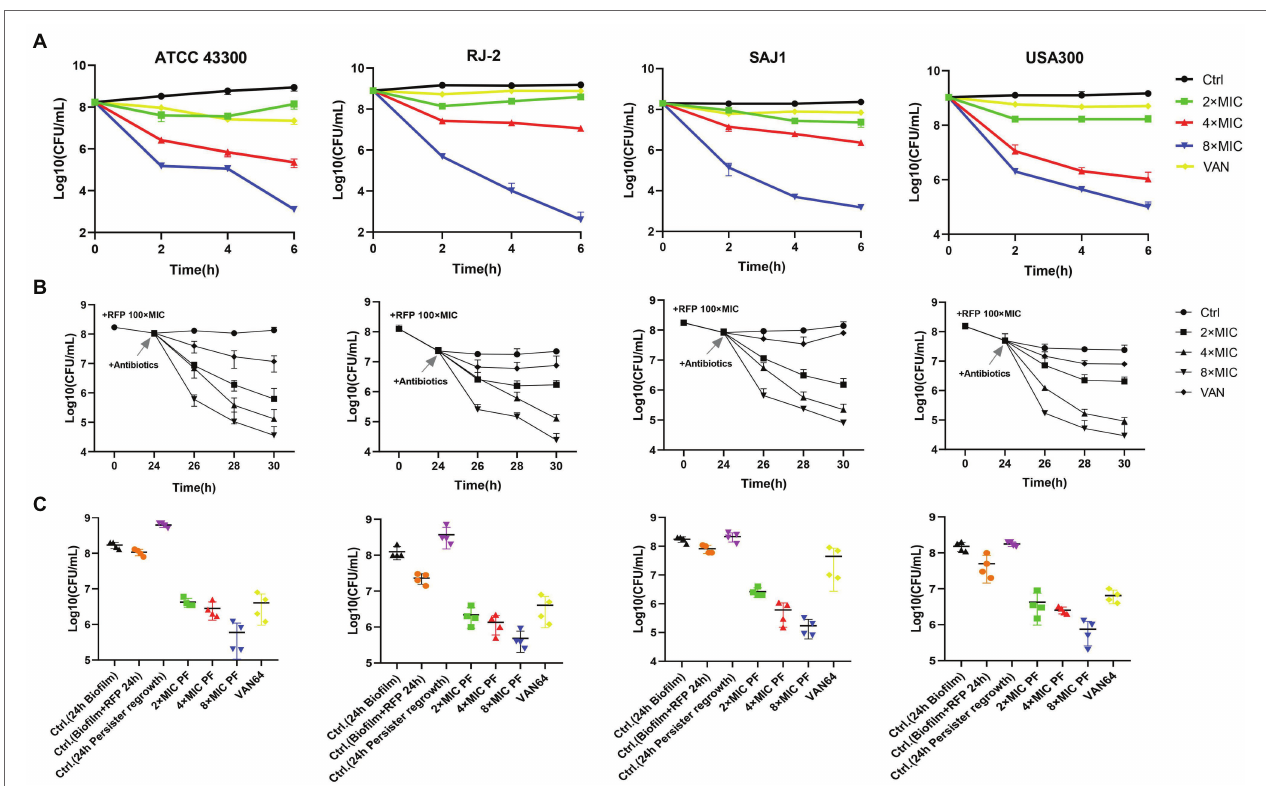
FIGURE 3 | Penfluridol shows strong bactericidal activity against methicillin-resistant S. aureus (MRSA) persisters. (A) Viability of four MRSA persister cells exposed to 2–8× MIC PF for 6 h, untreated, or 8× MIC vancomycin (VAN) as control. Biofilm persisters were induced by rifampicin (RFP) at 100× MIC, then treated with 2–8× MIC PF and 64 μ g/ml VAN for (B) 6 h, and (C) 24 h, respectively. Four strains of MRSA, from left to right, are ATCC 43300, RJ-2, SAJ1, and USA300, respectively. All the experiments were conducted triplicate; error bars represent means ±